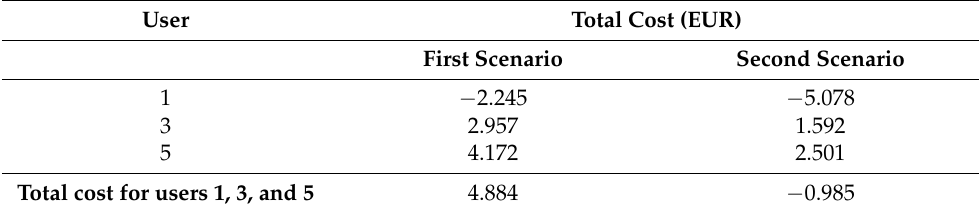
Table 6. Comparison of the three users in the two